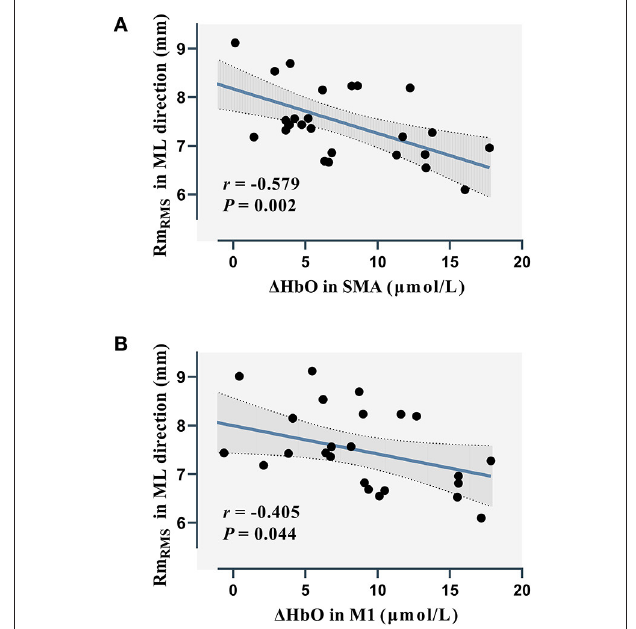
FIGURE 7 | Correlations between rambling parameters and brain activation in the SMA (A) and M1 (B) during RHK. 1 HbO, relative concentration changes of oxygenated hemoglobin; Rm RMS , root mean square of rambling; ML, medial-lateral; SMA, supplementary motor area; M1, primary motor